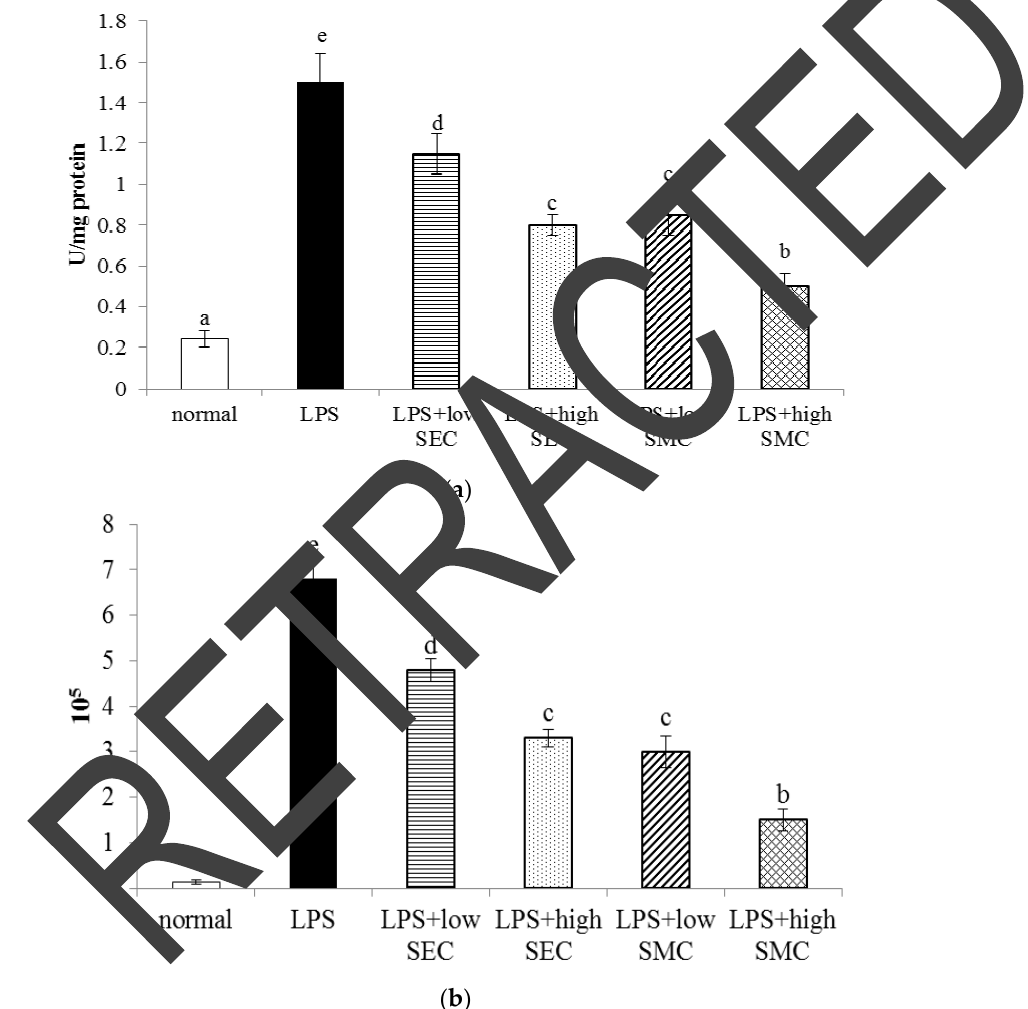
Figure 1. Lung MPO (myeloperoxidase) activity ( a ); and neutrophil count ( b ) of mice in normal group, LPS (lipopolysaccharide) group, LPS + low SEC ( S ‐ ethyl cysteine) group, LPS + high SEC group, LPS + low